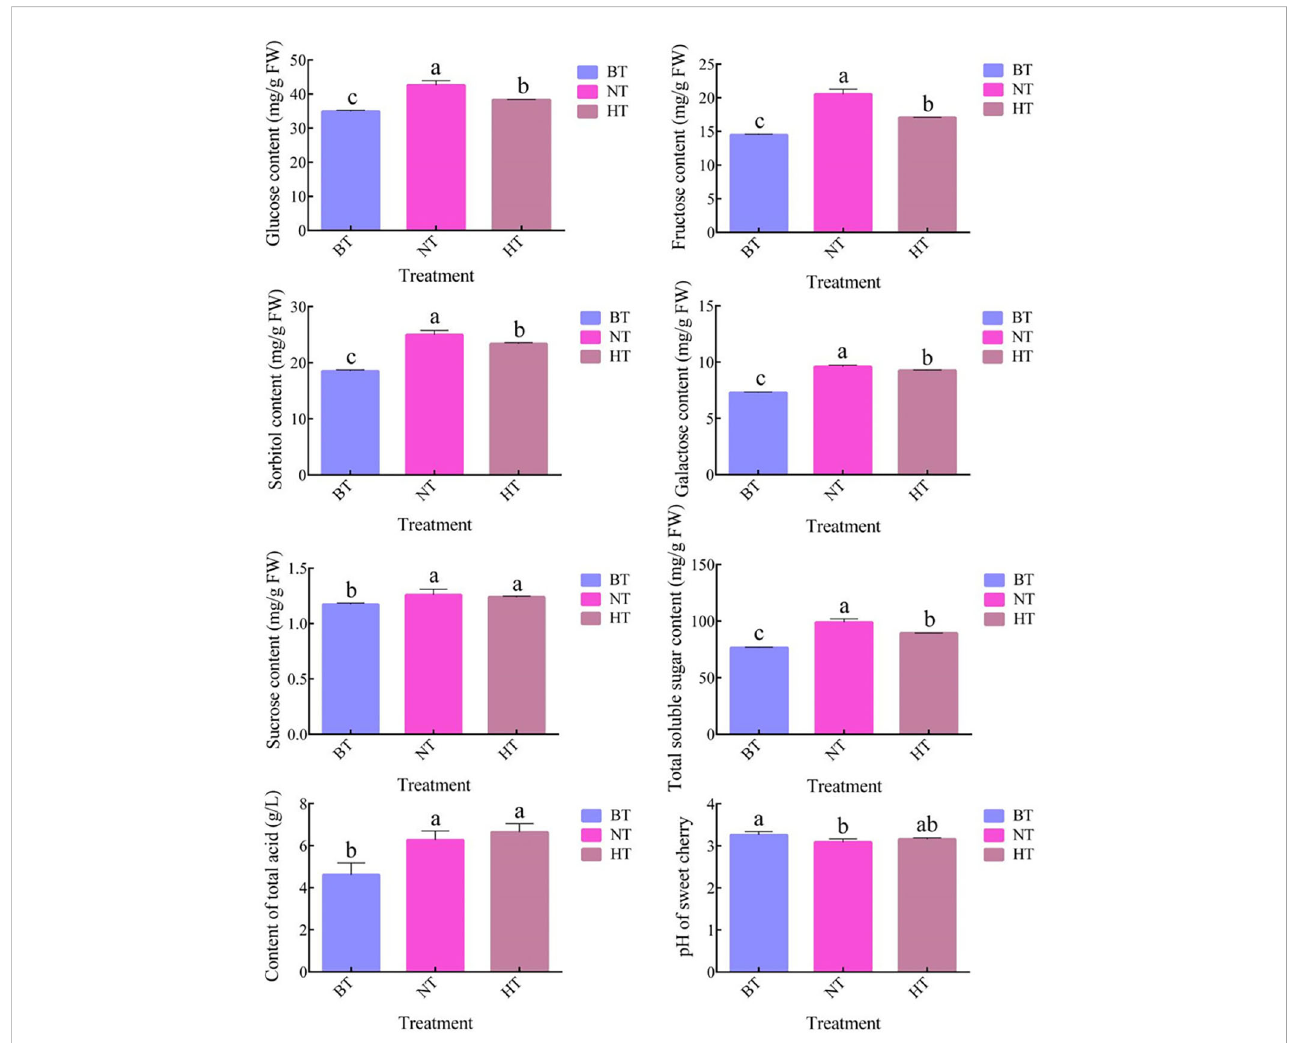
FIGURE 3 The soluble sugar content, total acid content and pH of sweet cherry peel in different treatments. The values represent the means ± SDs, n = 3. The different letters indicate signi fi cant differences among different treatments according to Duncan ’ s test (p <